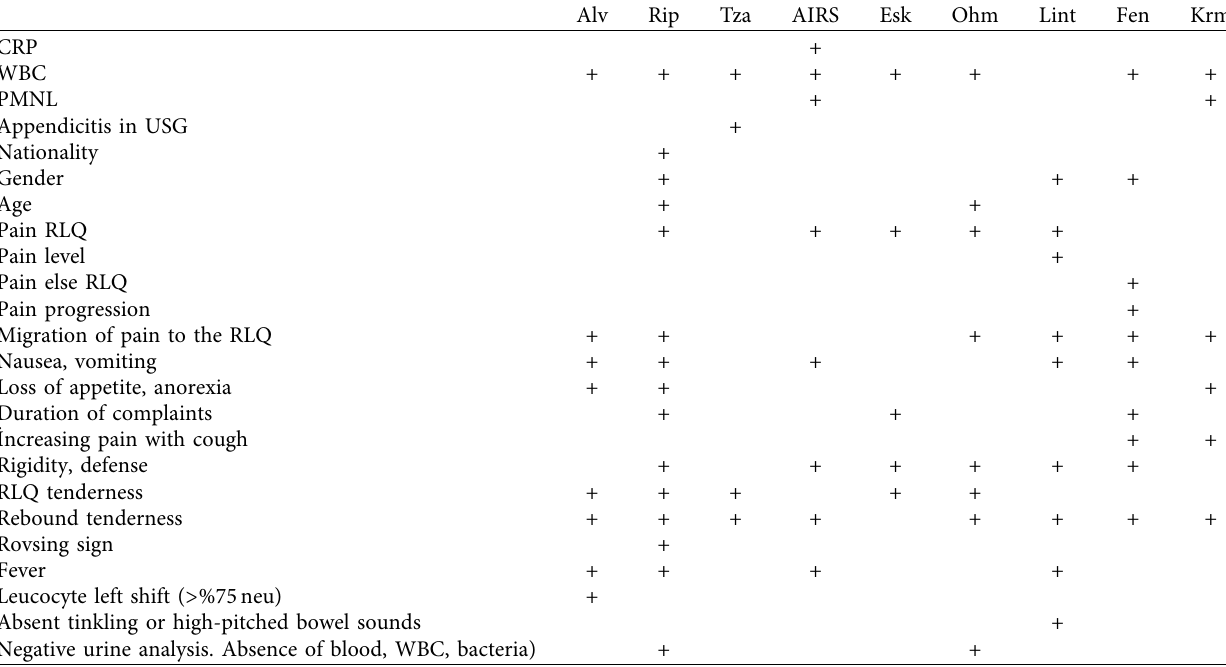
Table 1: Variables used in scoring